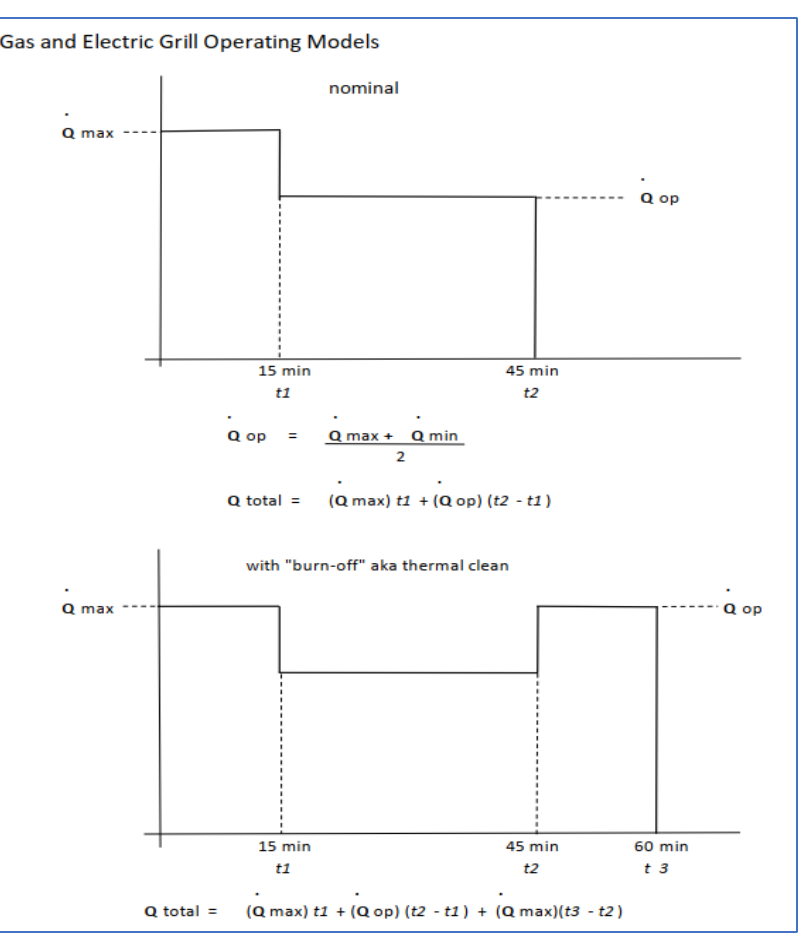
Figure 1. Gas/electric heat flux. Table 6. Heat fluxes, by grill type.